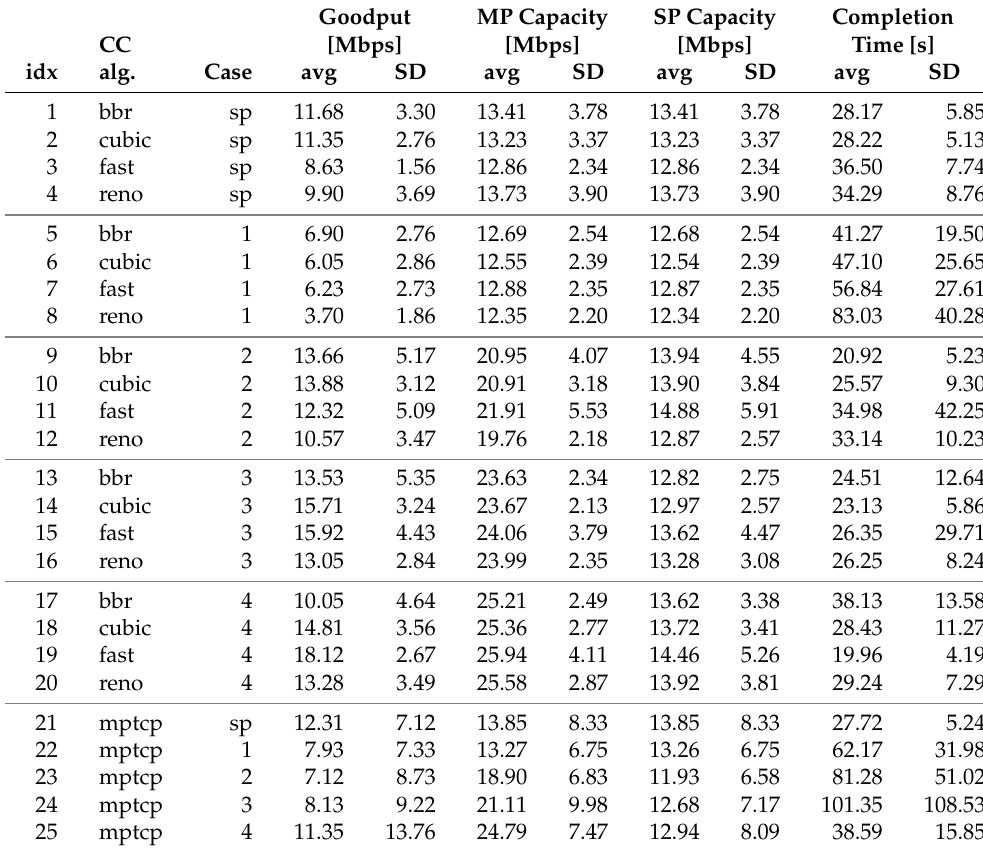
Table 4. Measurement results of Picoquic and MPTCP downloading a 40MB-sized file in the residential